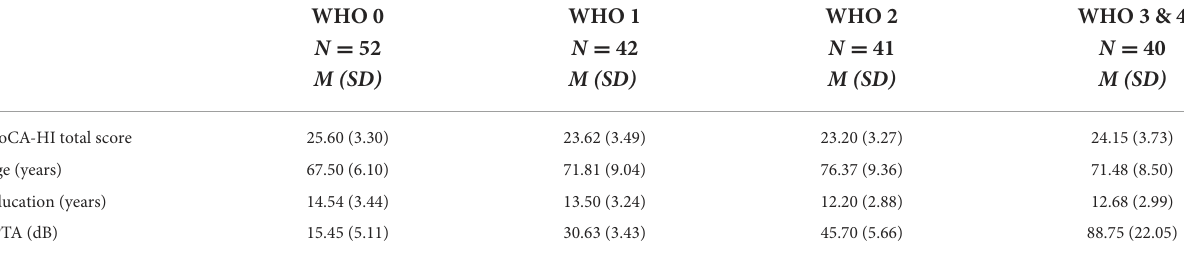
TABLE 2B Mean values of the MoCA-HI total score, age, education and 4PTA according to the WHO